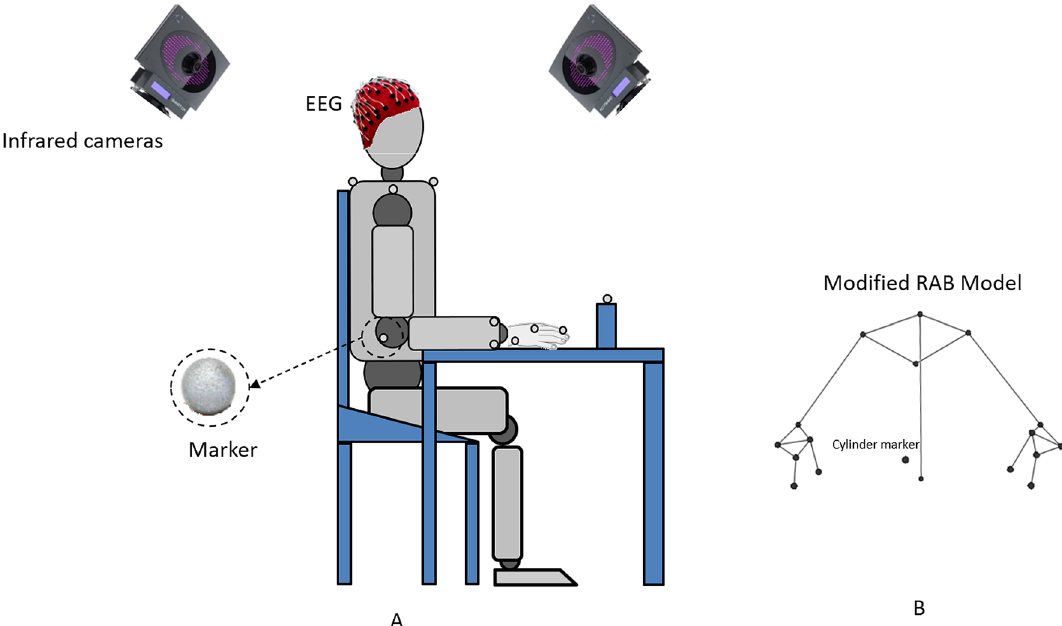
Figure 5. ( A ) The sagittal view of a subject in his initial position before performing the task. The spheres on the anatomical landmarks represent the passive reflective spherical markers which, in combination with infrared cameras, allow the motion capture. The subject wears an EEG cap. ( B ) Subject’s modelling according to the RAB kinematic protocol and the position of the cylinder marker.